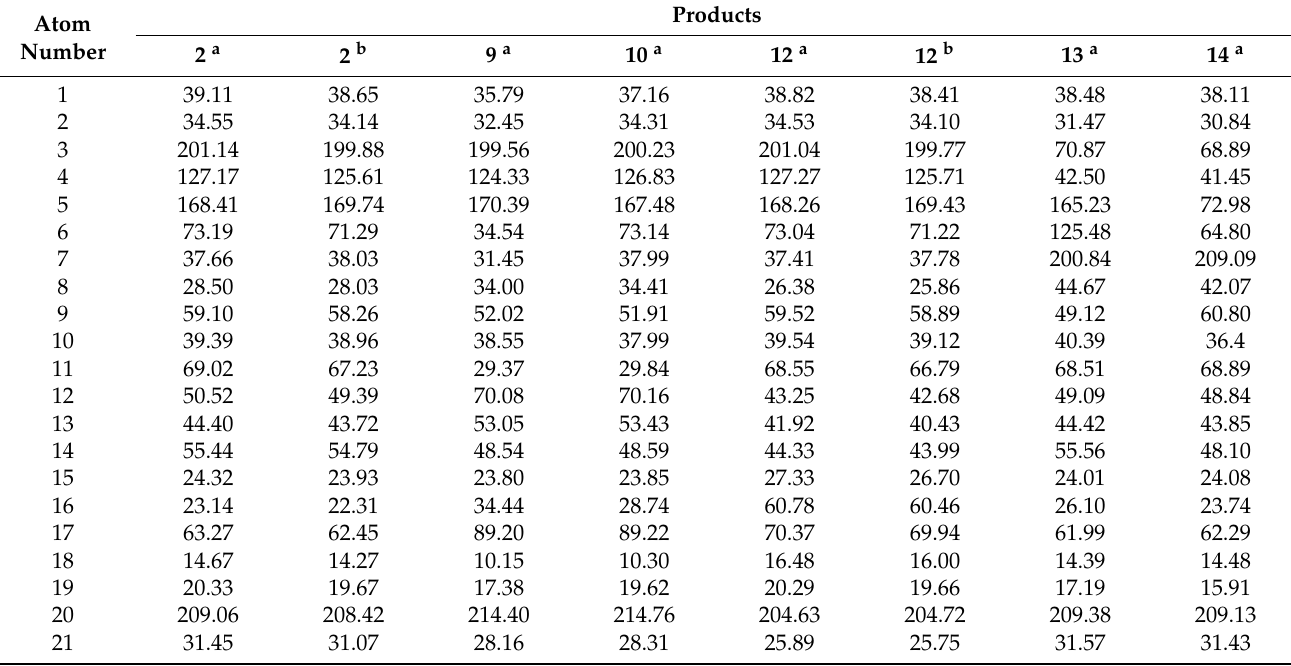
Figure 5. Pregnenolone ( 6 ) modification by Isaria farinosa KCh KW1.1 strain.